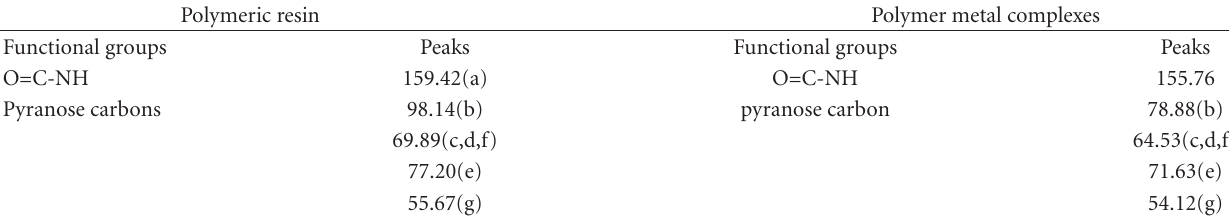
Table 4: Number of carbon atoms in di ff erent environment of SUr and its polymer metal complexes. Polymeric